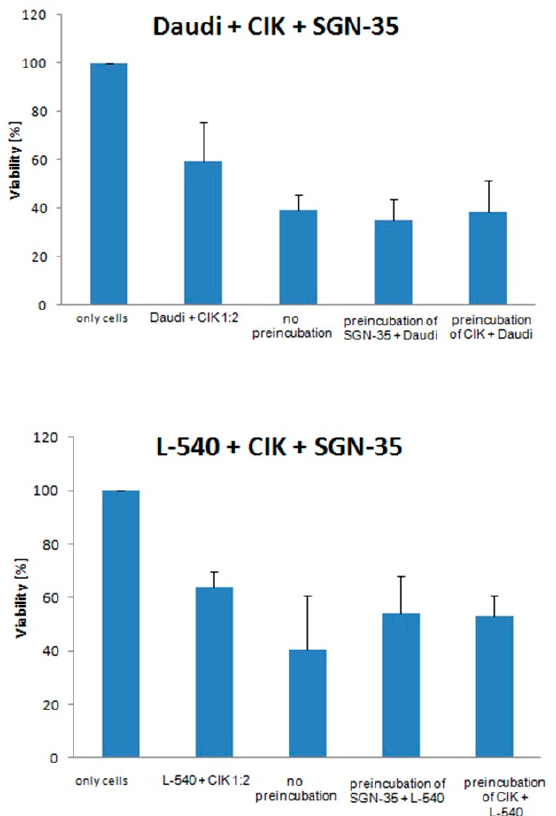
Figure 4. The effect of a suboptimal number of CIK cells (1:2 for Daudi and KI-JK and 2:1 for L-540) and a suboptimal concentration of SGN-35 (10 ng·mL − 1 ) on the cell lines. The cell lines were once preincubated with CIK cells only and once with SGN-35 only. After 24 h, the SGN-35 and the CIK cells, respectively, were added and incubated for 72 h. In another experiment, the lymphoma cell lines were incubated with CIK cells and SGN-35 for 72 h without preincubation. As a control, the lymphoma cells were also incubated with CIK cells only. The results represent data from three different buffy coats and were done in triplicates each time. Cell viability was measured with an MTT assay. Data are presented as mean ± SD ( p < 0.05).